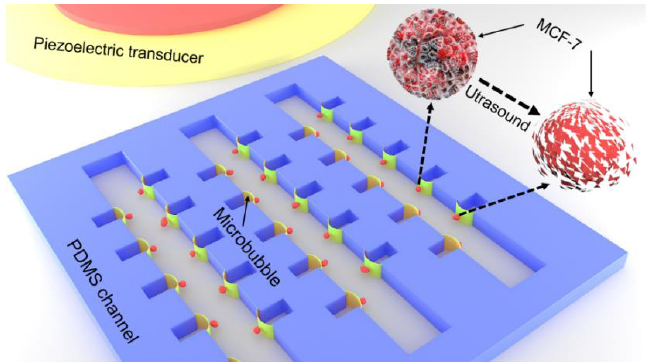
Figure 1. Schematic of experiment setup. The polydimethylsiloxane (PDMS) channel and piezoelectric ceramic transducer (PZT) were placed on the surface of the glass substrate. The PZT was employed to excite microbubble oscillation.